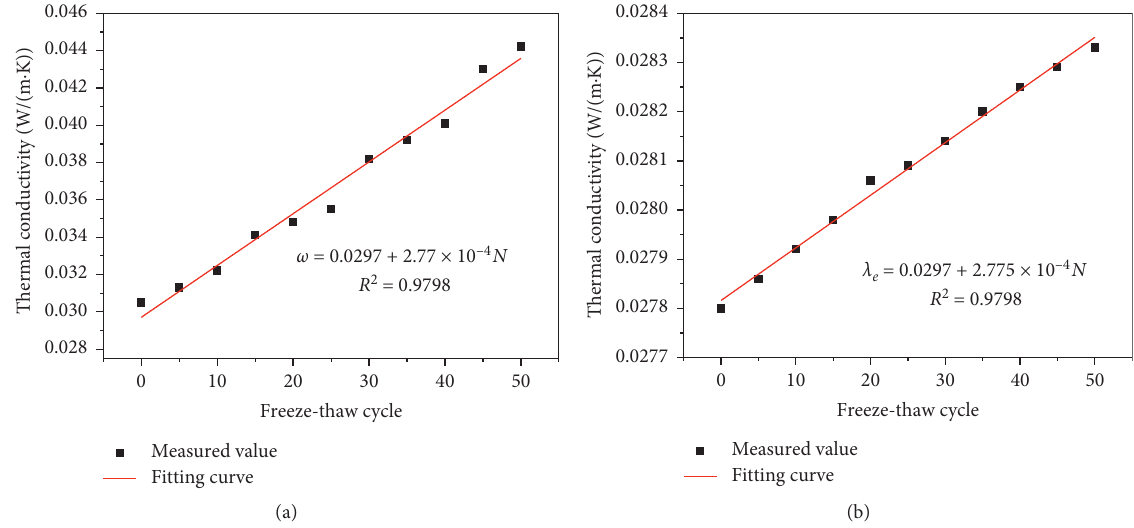
Figure 9: Effect of freeze-thaw cycles on thermal conductivity of thermal insulation materials. (a) Polyphenolic. (b)